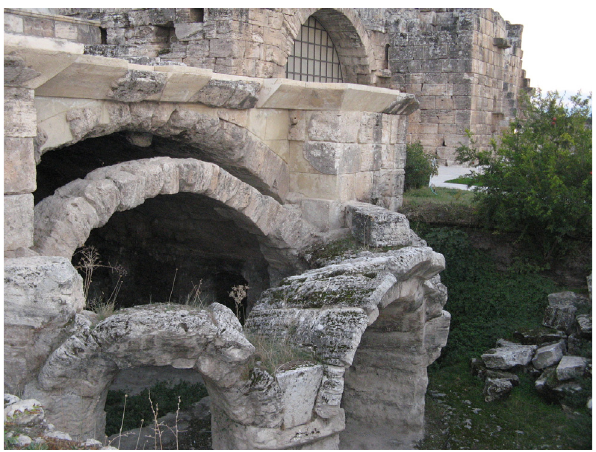
Figure 32. Three-lobed apse of stone at the Roman Baths in Hierapolis (Turkey).